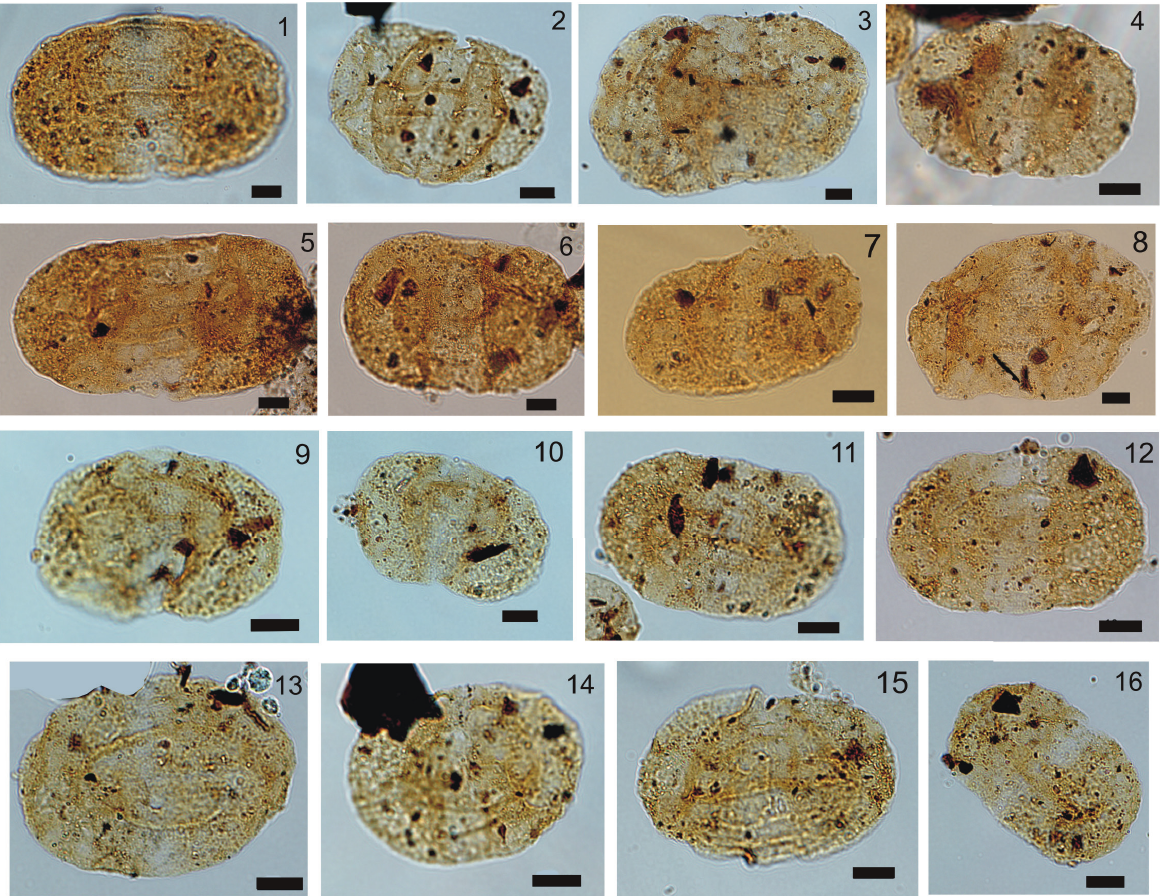
(48 hours, KOH 15’). Scale bar= 10 3